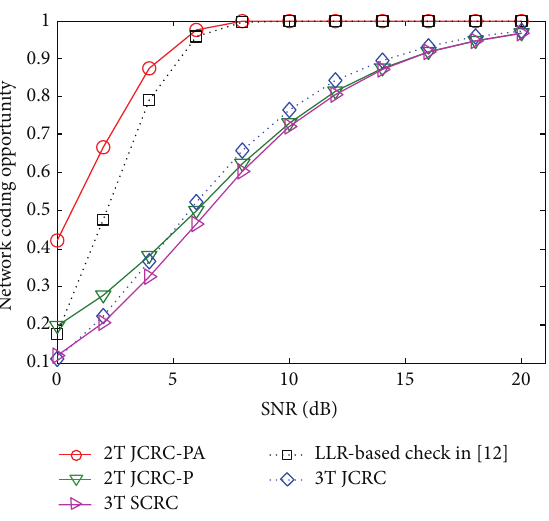
Figure 3: NC opportunities comparison.